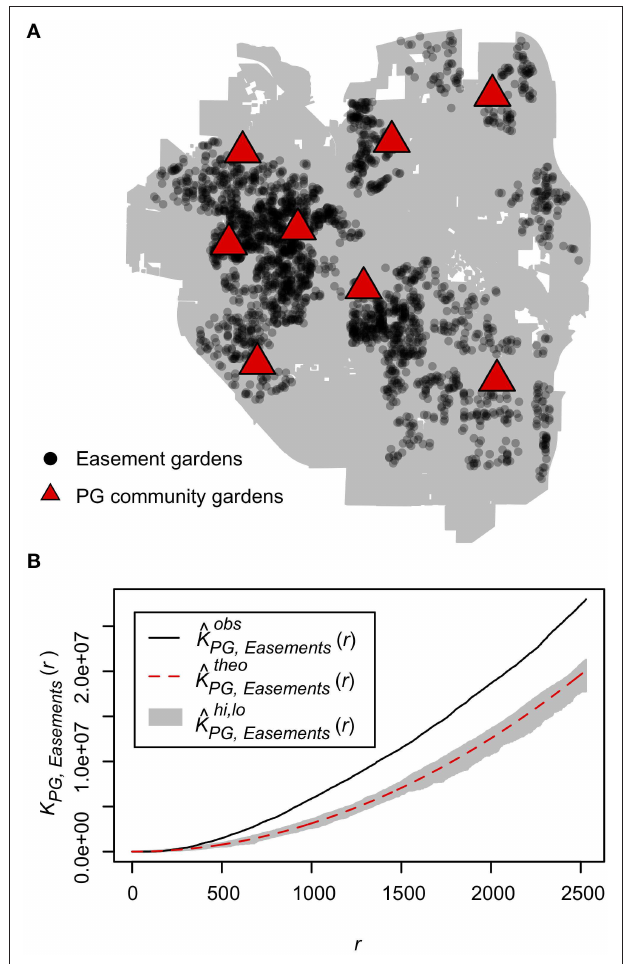
FIGURE 3 | Easement gardens cluster around community gardens. (A) Spatial distribution of easement gardens (black dots) and Project Grow (PG) community gardens in the city limits of Ann Arbor (gray polygon). (B) The observed Cross-K function (black line), which calculates the number of easement gardens within a radius r of every community garden compared to the mean (red dashed line) for n = 999 Monte Carlo simulations where easement and community garden labels are randomly assigned along with the upper and lower simulation envelope (gray band), which signifies a significance level of alpha = 0.002 for the Monte Carlo